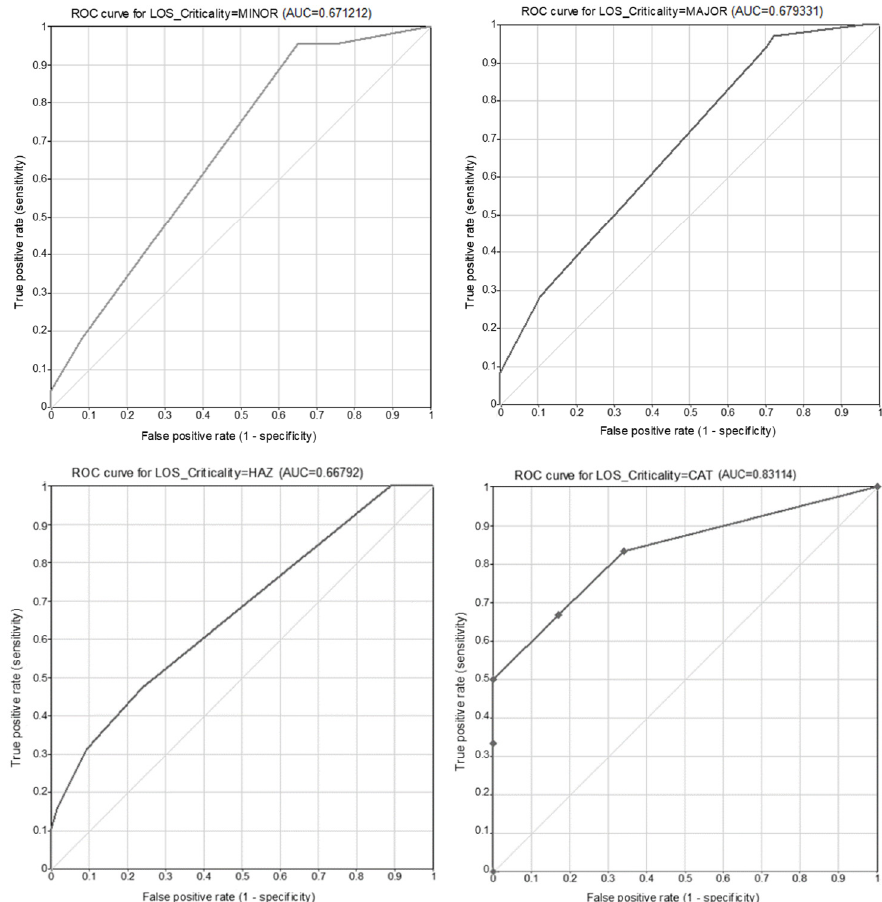
Figure 10. ROC curves of the target variable stages for the validation of the model.